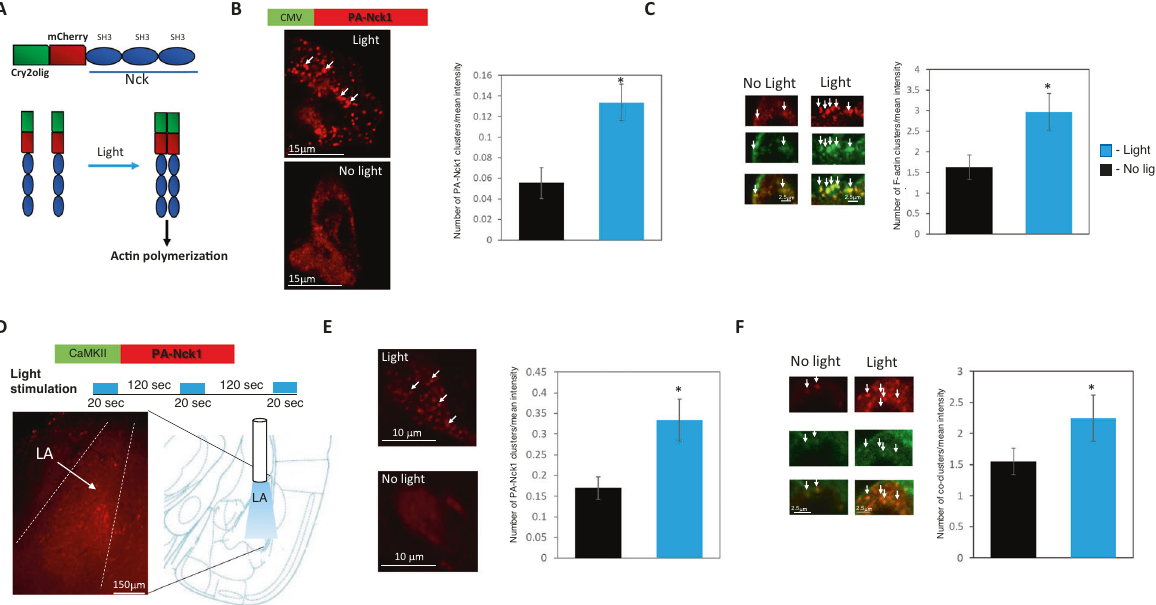
Fig. 2 Blue light stimulation of HEK293 cells and lateral amygdala neurons leads to the formation of PA-Nck1 and F-actin clusters. A PA- Nck1 contains the 3 SH3 domains of Nck1 conjugated to Cry2olig and mCherry. Blue light stimulation leads to PA-Nck1 clustering. Studies in culture cells have shown that such clustering leads to actin polymerization. B HEK293 cells were transfected with PA-Nck1 under the control of the CMV promoter. Stimulation of the cells with light leads to a signi fi cant increase in PA-Nck1 clusters ( t (22) = 3.367, p = 0.003) (normalized to fl uorescence intensity) when compared with cells that were kept in a dark condition. Representative cells that were transfected with PA-Nck1 and activated by light or remained in the dark are shown. C PA-Nck1 is co-localized with F-actin in multiple spots (see arrows) in light stimulation HEK293 cells. F-actin clusters are increased (normalized to fl uorescence intensity) signi fi cantly after light stimulation ( n = 7) compared to cells stored in dark ( n = 6) ( t (11) = 2.367, p = 0.036). D Mice were microinjected with AAV expressing the PA-Nck1 under the control of the short CaMKII promoter into the lateral amygdala (LA) and stimulated with blue light through optic fi bers. PA-Nck1 construct and light stimulating protocols are shown. Representative expression of PA-Nck1 in LA as observed by mCherry reporter protein expression is shown. E Stimulation of LA neurons with light leads to a signi fi cant increase ( t (28) = 2.744, p = 0.01) in PA-Nck1 clusters (normalized to fl uorescence intensity) in LA compare with neurons that were not stimulated with light. Representative LA neurons that express PA-Nck1 and are activated by light or remain in the dark are shown (single neurons for dark and light conditions are shown). F PA-Nck1 is co-localized with F-actin in multiple spots (see arrows) in the light-activated neurons in LA. Application of light to LA leads to a signi fi cant increase in PA-Nck1 and F-actin co-localization ( t (18) = 2.158, p = 0.045). Values are mean ± SEM. B , C , E , F Independent samples t onto LA after the last CS (three pulses of 20-s light similar to the ( F (1.588,33.343) = 0.534, p = 0.551) (Fig. 3B). Next, the mice were light stimulation protocol performed during training above) tested for contextual fear conditioning LTM 24 h after training. (Fig. 3I). Freezing during training was not different between the There is no signi fi cant difference between mice that were groups ( F (1,10) = 1.899, p = 0.198) and there is no treatment × tone subjected to light stimulation to activate PA-Nck1 ( n = 12) and mice that were not exposed to light ( n = 13) ( t (23) = 1.938, trial interaction ( F (1.085, 10.849) = 0.849, p = 0.386) (Fig. 3J). Animals p = 0.065) (Fig. 3C). These mice were tested for auditory fear were tested for contextual long-term fear memory formation 24 h memory 24 h afterward. Long-term auditory fear conditioning is after training. Post-training light stimulated mice ( n = 6) were not impaired in animals that were stimulated by light compared with signi fi cantly different in long-term contextual fear conditioning animals that were not exposed to light ( F (1,21) = 10.369, p < 0.005) memory when compared to non-stimulated animals ( n = 6) ( t (10) = 0.601, p = 0.561) (Fig. 3K). There is also no effect on long- (Fig. 3D). There is no treatment × tone trial interaction ( F (4,84) = 0.743, p = 0.565). Applying light alone ( n = 7) (Fig. 3E) term auditory fear memory ( F (1,10) = 0.026, p = 0.875) with no